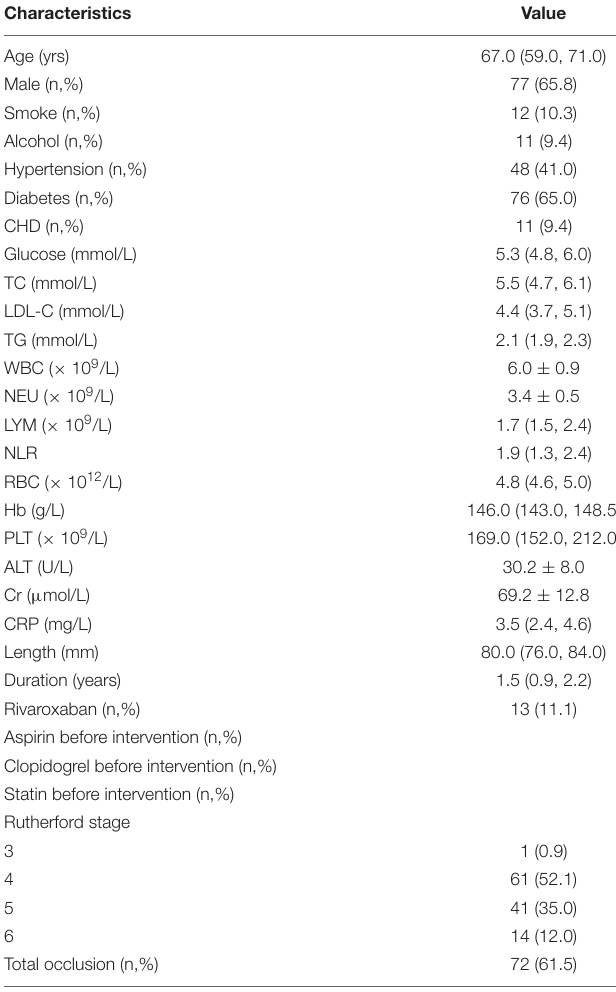
TABLE 1 | Patient baseline information.